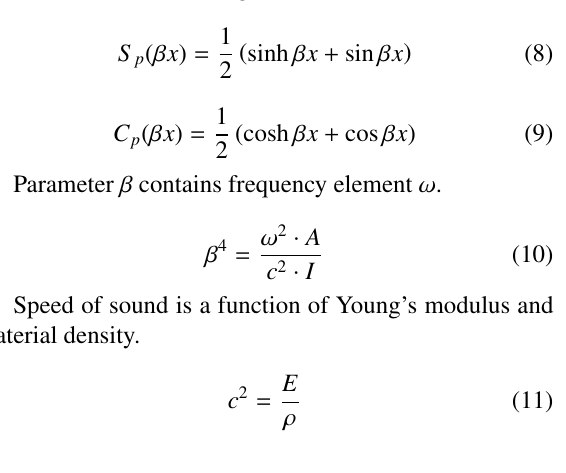
Table 3. Simulation parameter